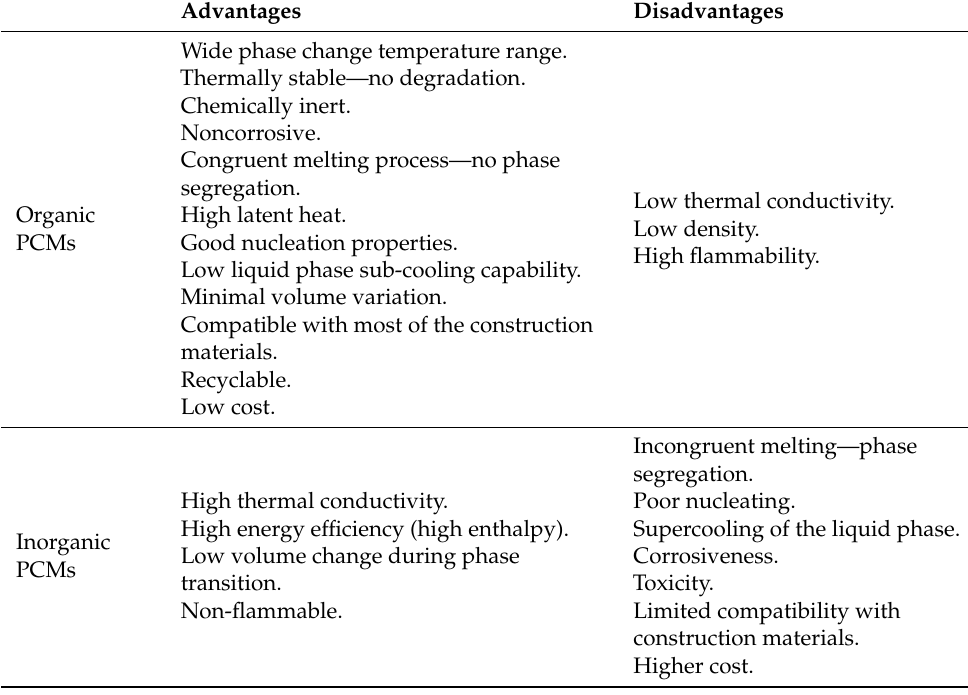
Table 3. Advantages and disadvantages of organic and inorganic phase change materials